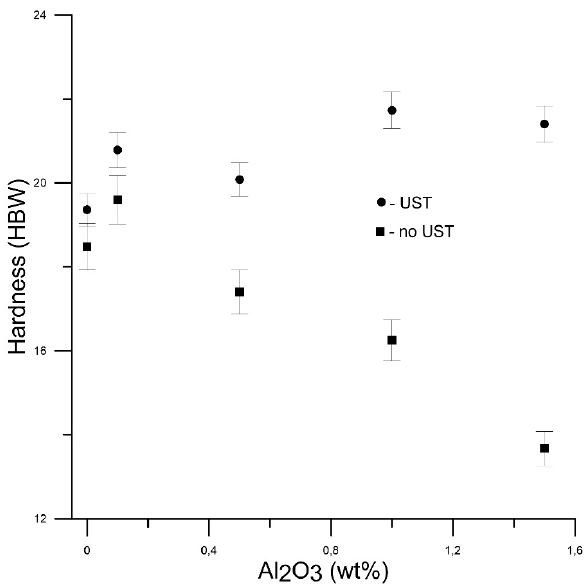
Figure 3. The dependence between the Brinell hardness and Al 2 O 3 content in the 1100 aluminum alloy.